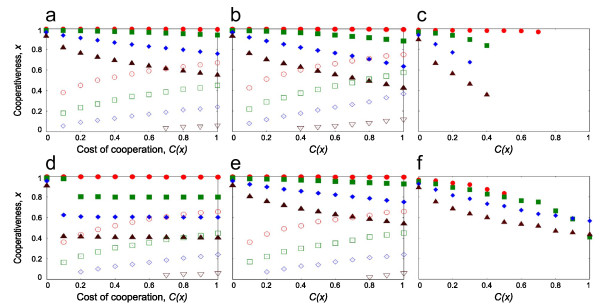
Equilibrium frequency of cooperators as a function of the cost of the Public Good Game (C(x)). The panels depict the results of the individual-based simulations for non-zero stable fix points (filled marks) and instable fix points (open marks). The groups are composed of 5 individuals either picked randomly from the population (a, b, c), or from the same site in the model with spatial population structure (d, e, f). In cases a, d competition occurs only between groups, in the simulations of b and e, both individuals and groups compete with each other with compulsory participation. Finally in the cases of c, f both individual and group level selection are present and participation in the group stage is voluntary. The different marks are depicted to different threshold values (●,○: T = 5; ■,□: T = 4; ♦,◊: T = 3; ▲, Δ: T = 2).